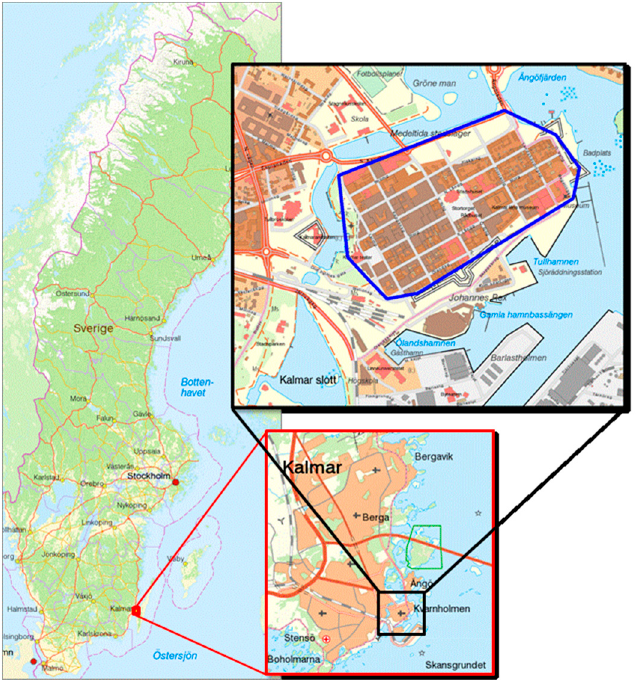
Figure 2. The study area Kvarnholmen in the city of Kalmar, in the southeast of Sweden.